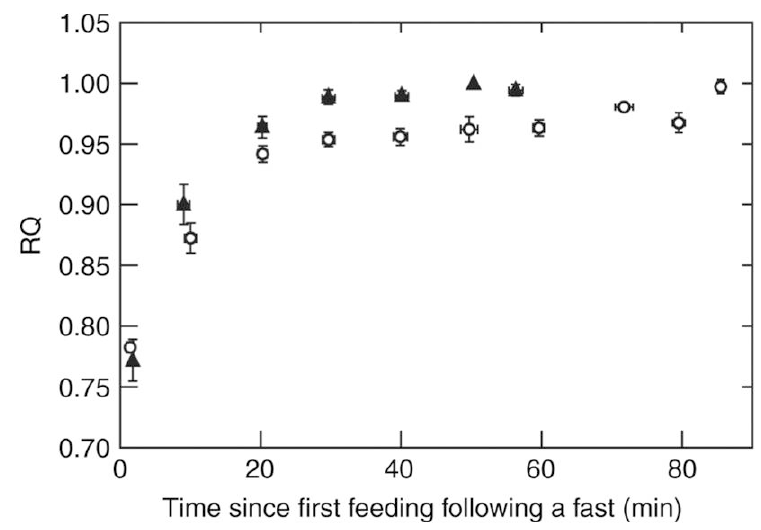
Figure 3. Respiratory quotients (RQ) during hover-feeding over time after fasting in rufous hummingbirds ( Selasphorus rufus ) (triangles) and nectar bats ( Glossophaga soricina ) (circles) (From [3]). Flight muscles oxidize mainly fat (RQ values close to 0.7) in fasted animals during hovering. RQs rise to about 1.0, indicating that flight muscles shift to carbohydrate oxidation as a result of repeated hover-feeding on sucrose solutions.